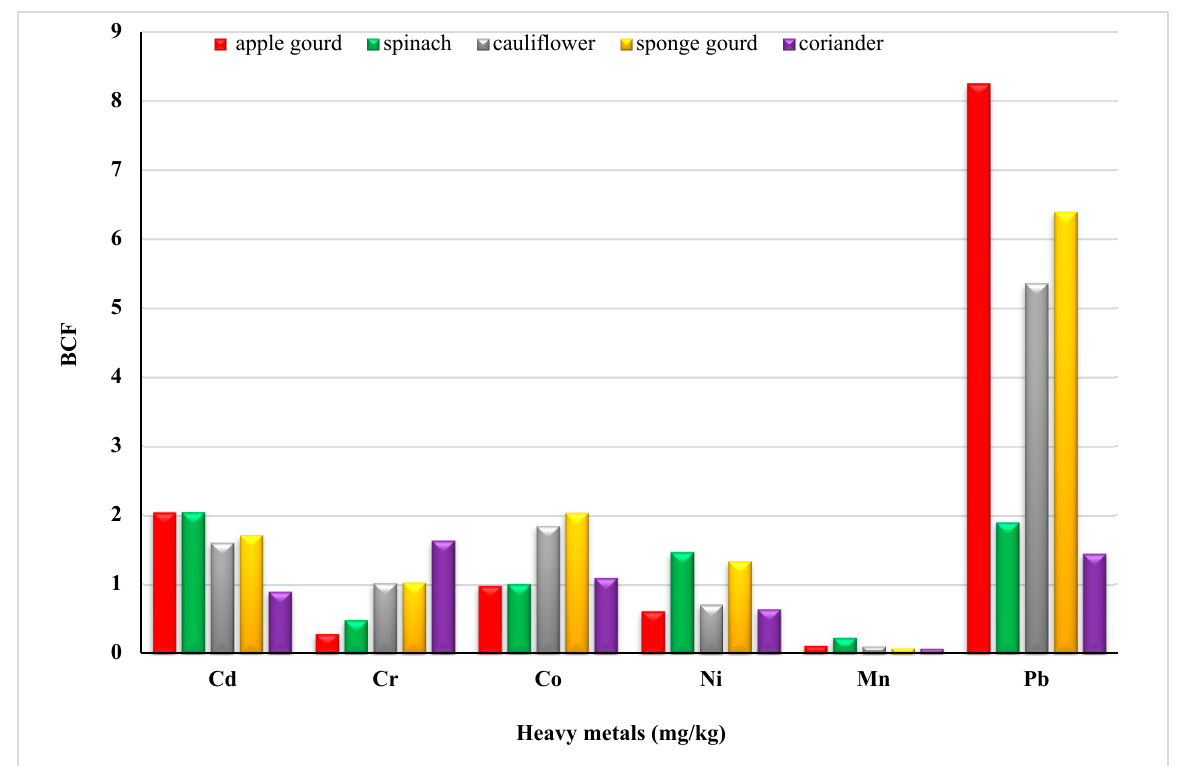
Figure 1. Bio-concentration factor of heavy metals in vegetables.